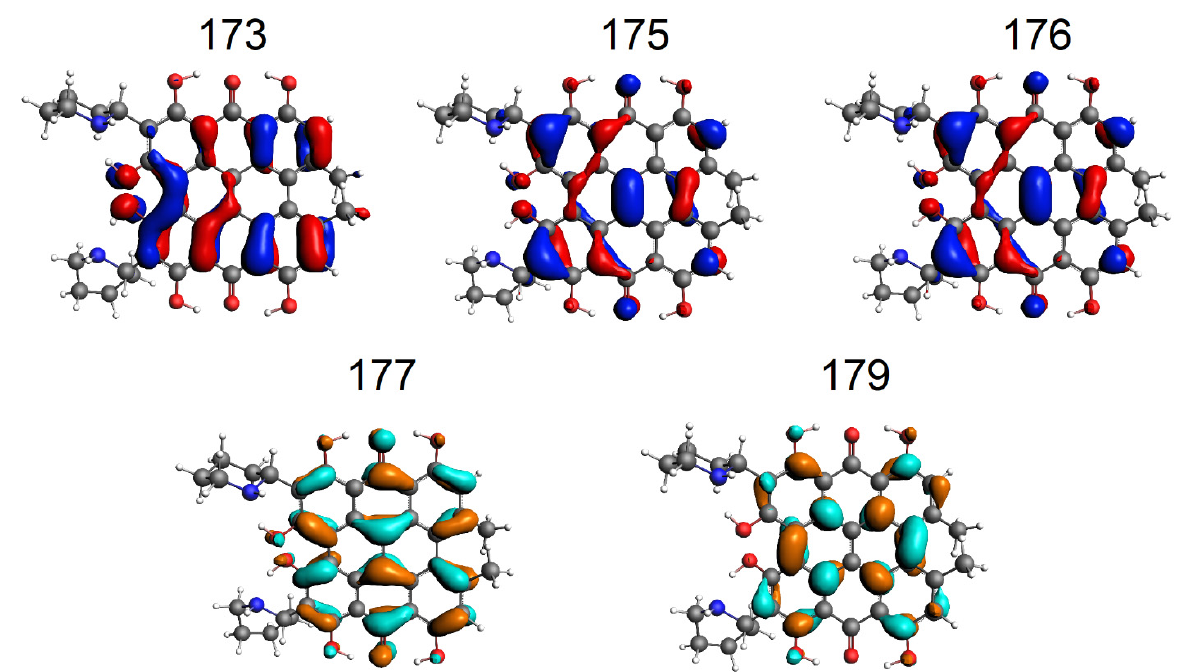
Figure 12. The shape of the orbitals for structure 32 (the lowest energy structure of fagopyrin F). 176—HOMO and 177—LUMO orbitals.